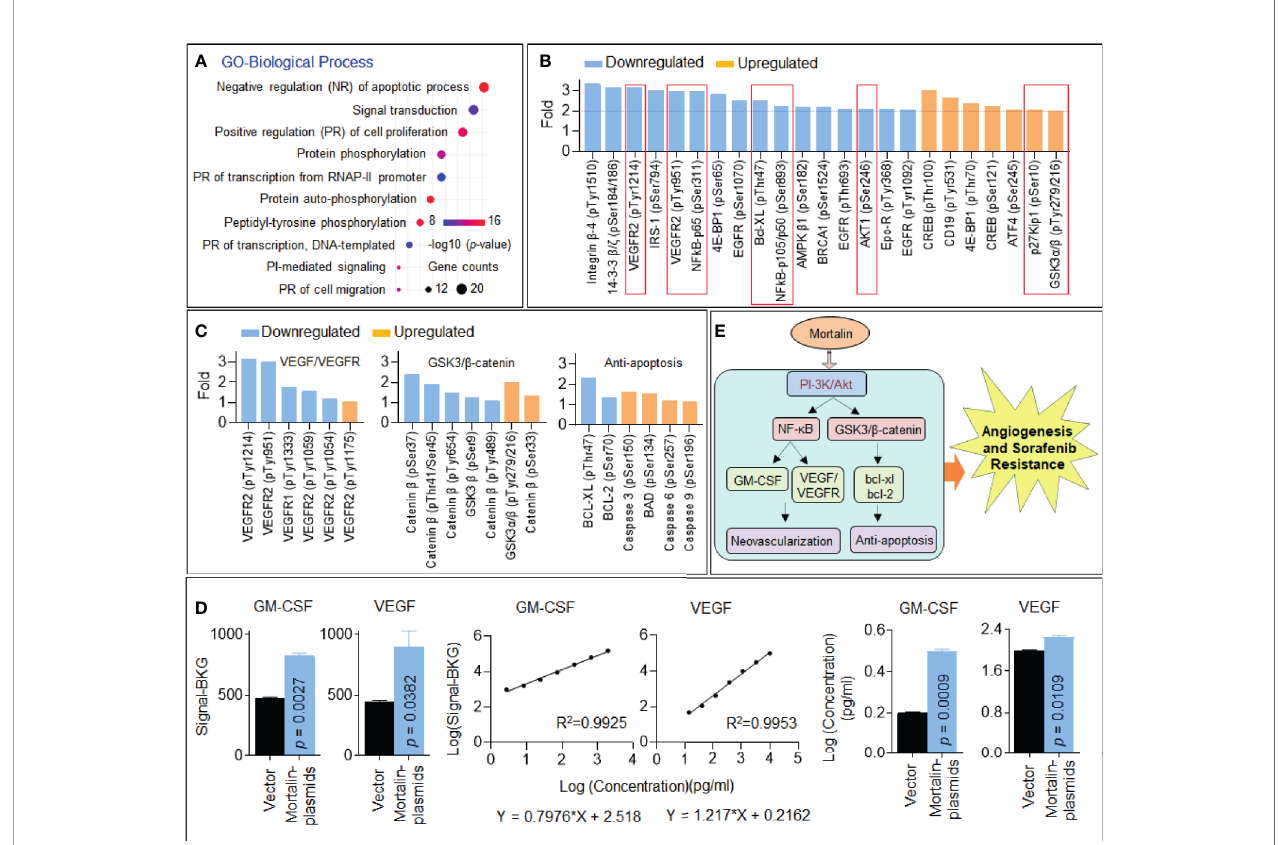
FIGURE 3 | Identi fi cation of phosphatidylinositol 3-kinase (PI3K)/Akt as an important downstream factor regulating vascular endothelial growth factor (VEGF) and glycogen synthase kinase (GSK)3/ b -catenin in hepatocellular carcinoma (HCC) cells. (A) Gene Ontology (GO) biological process analysis of the 54 proteins enriched in the PI3K/Akt pathway. (B) The proteins in the PI3K/Akt signaling pathway with the most signi fi cant changes in phosphorylation (greater than 2-fold). (C) The changes in the phosphorylation of proteins involved in VEGF/vascular endothelial growth factor receptor (VEGFR) signaling, GSK3/ b -catenin signaling, and apoptosis. The data of each phosphorylation site level exhibited were the mean of two biological replicates. (D) The fl uorescence signal values, standard curves, and calculated concentrations of granulocyte-macrophage colony-stimulating factor (GM-CSF) and VEGF in mortalin-plasmid- and vector-transfected HepG2 cells in the angiogenic antibody array. Means and standard deviations were calculated from replicate samples, and the differences were analyzed using Student ’ s t -test. (E) An outline map speculating the potential mechanisms involved in mortalin-induced angiogenesis and sorafenib